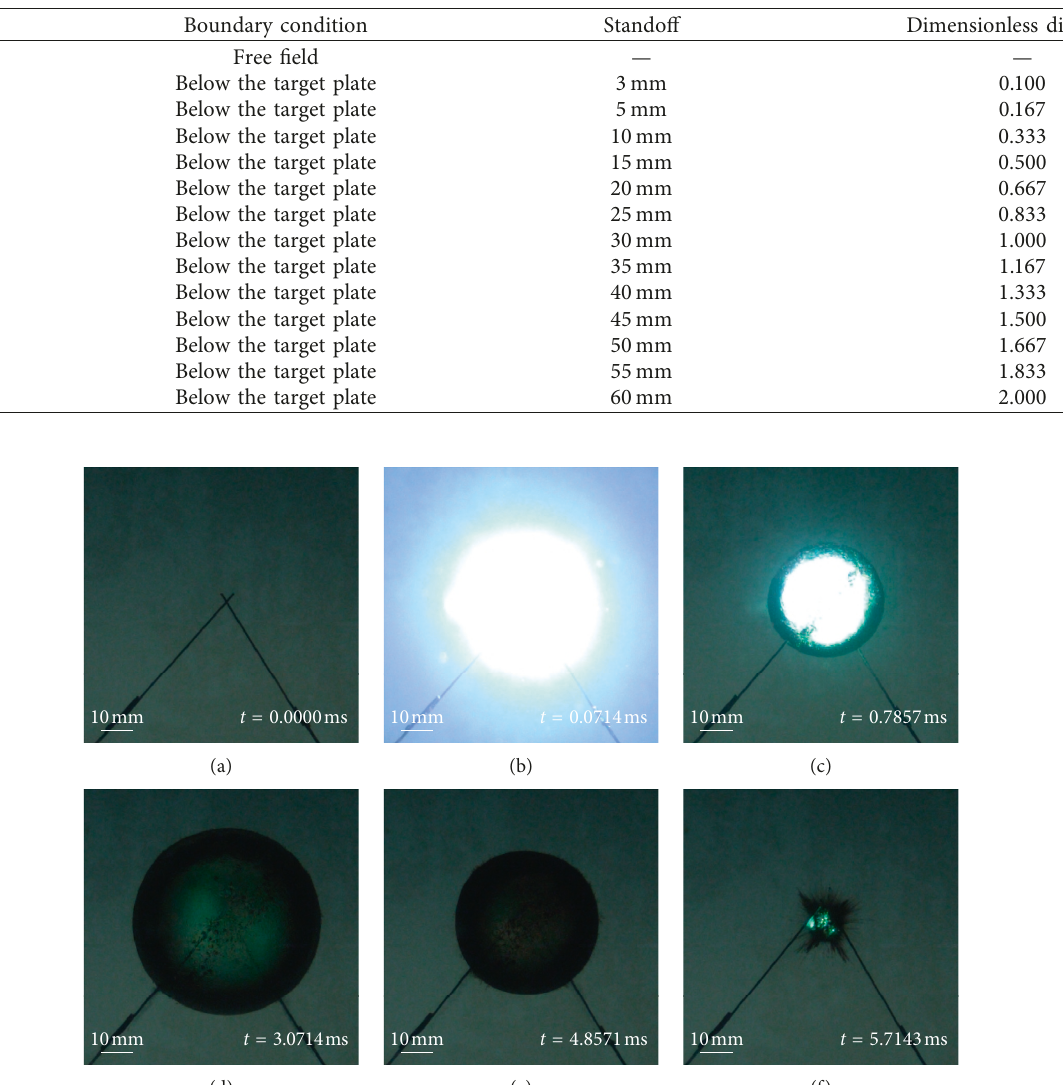
Figure 5: Evolution of the first cycle of the spark-generated bubble’s expansion and collapse in a free field. (a) t � 0.0000ms. (b) t � 0.0714 ms. (c) t � 0.07857ms. (d) t � 3.0714 ms. (e) t � 4.8571 ms. (f) t �